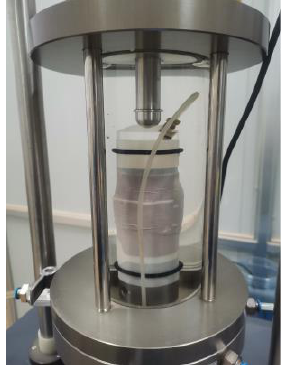
Figure 4. Sample under loading.